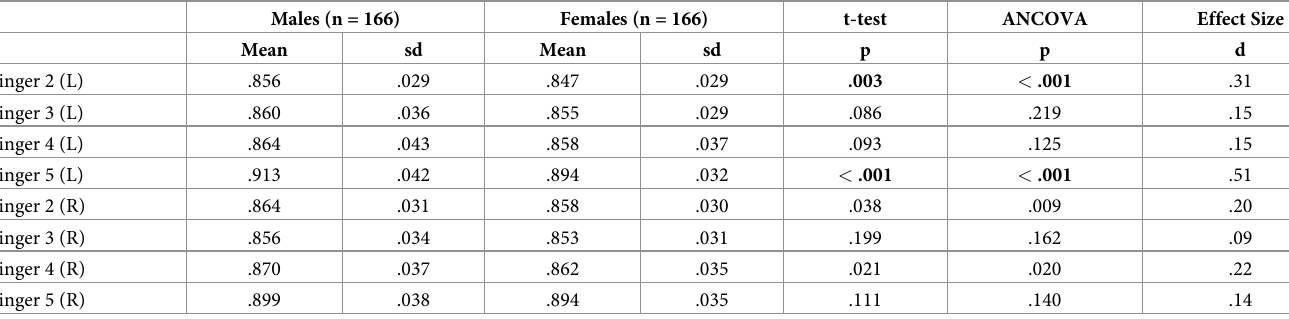
Table 2. Sex differences in finger tapering in U.S.